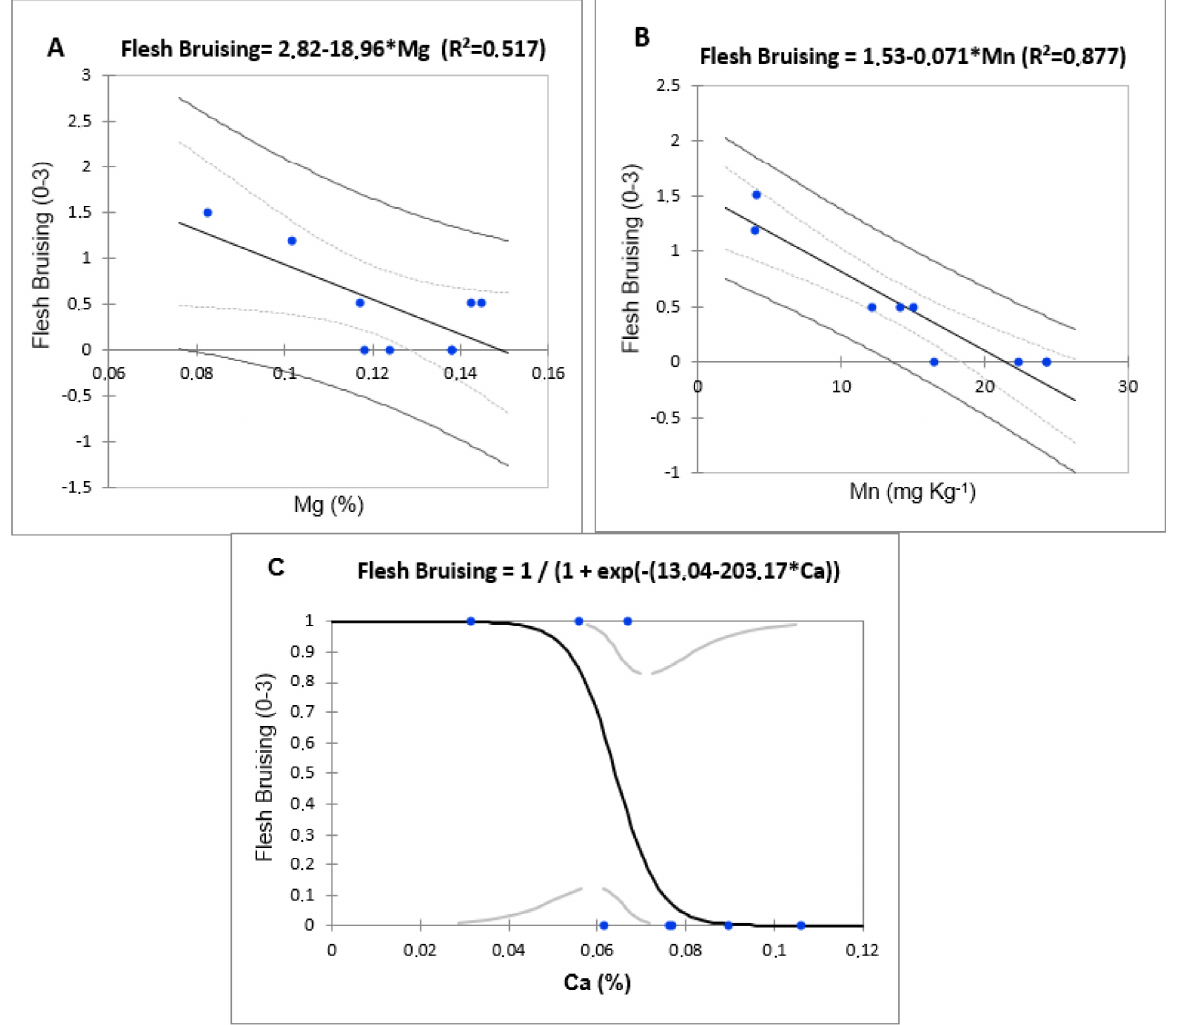
Figure 4. Magnesium and manganese content and its relationship with flesh bruising: ( A , B ) Lineal regression for BV farm (DM-22, ST = 0 weeks); ( C ) Logistic regression for damage and calcium content in CS farm (DM-22, ST= 5 weeks). DM: Dry matter, ST: storage time. Farms codes: CS and BV.